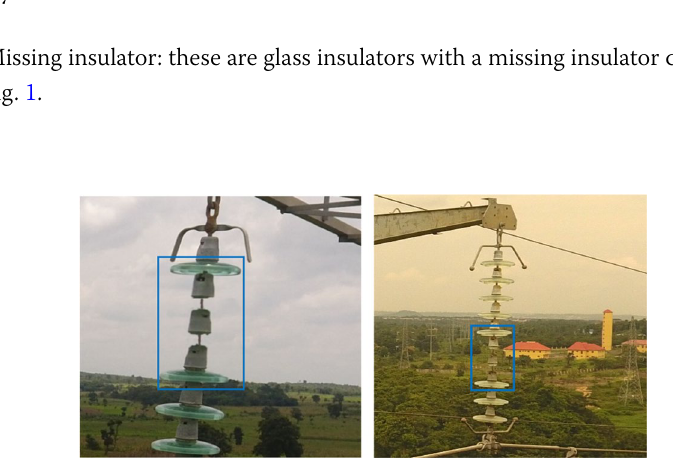
Fig. 1 Missing glass insulator faults